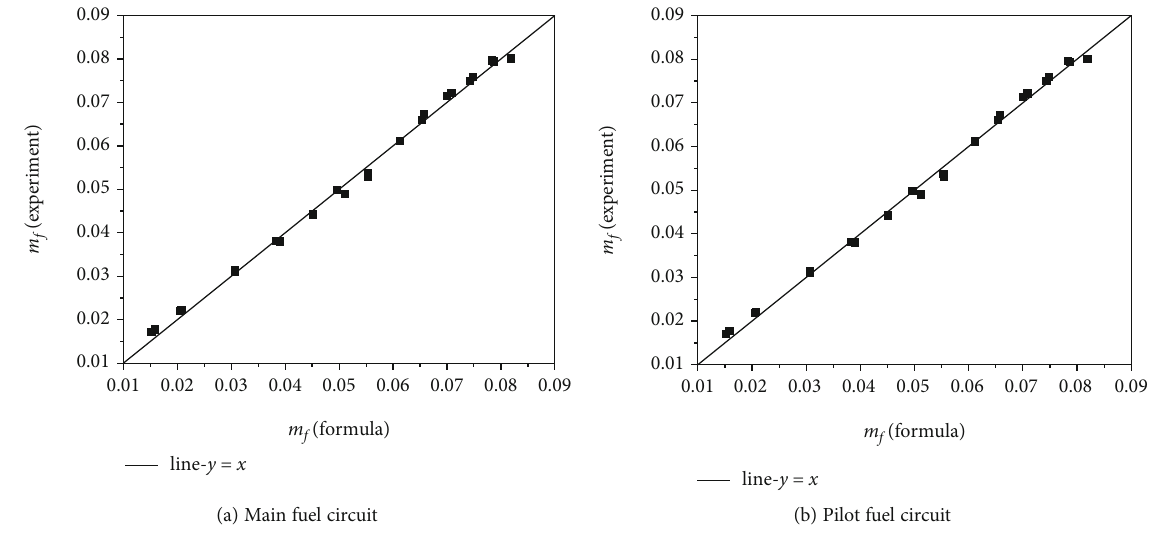
Figure 11: Relative error of empirical